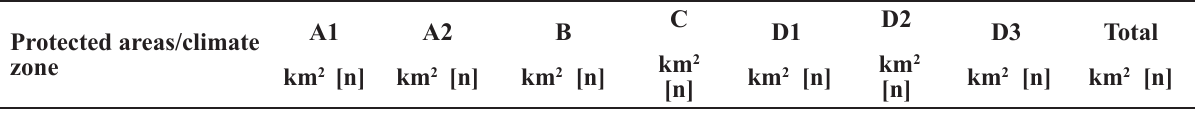
Table 5: The estimated numbers [n] and areas of extents of different categories of protected areas according to phyto-climatic